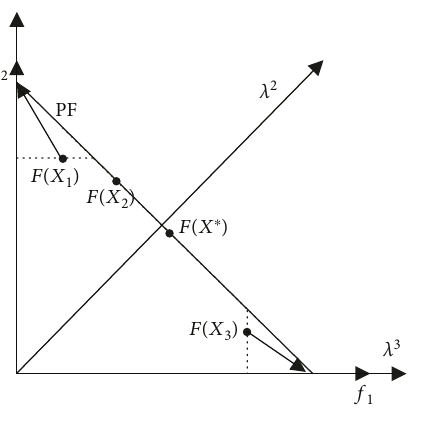
Figure 3: Pareto front as a line.